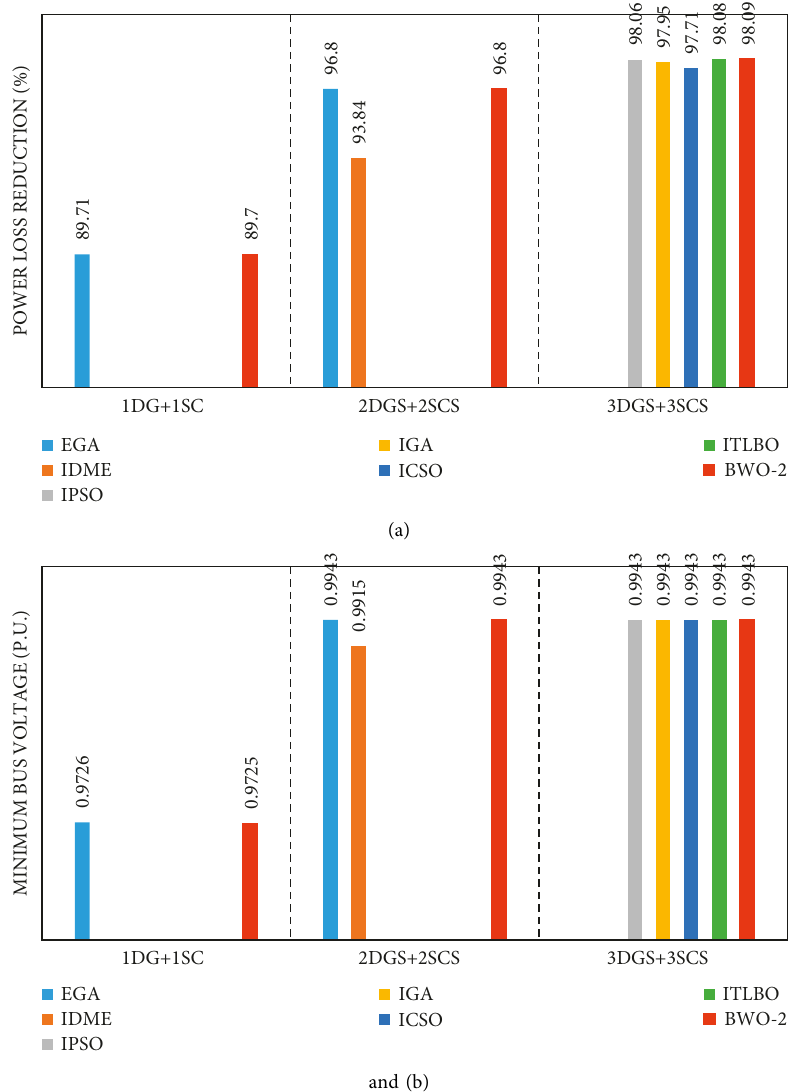
Figure 18: Performance comparison of BWO-2 against other optimization algorithms for (a) power loss reduction and (b) minimum bus